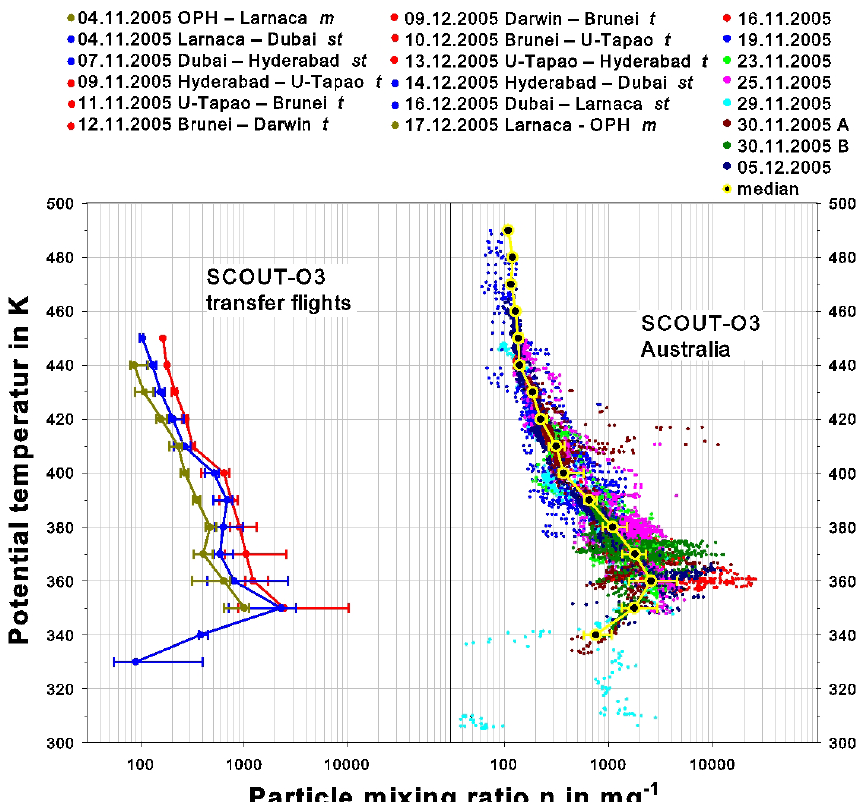
Fig. 4. Vertical profiles of COPAS particle mixing ratios as function of potential temperature (in K) for the transfer to/from Darwin and the local flights in Australia. The symbols are medians of 10K bins and the bars denote 25% and 75% percentiles. Left panel: Vertical n 10 profile measurements during the intermediate descents and ascents from the transfer flight airports between Oberpfaffenhofen (“OPH”, Germany) and Darwin (Australia). The denominations (and colours) refer to the geographical locations of these airports with “m” (dark green), “st” (blue), and “t” (red) standing for “mid-latitude”, “sub-tropical”, and “tropical”. Similarly, the mid-latitude and sub-tropical data are comprehended in the blue and green curves. Right panel: Vertical profiles of n 10 obtained over Darwin. Here the colour code refers to the flight dates on the right side of the legend and the small points represent 15s averages. The potential temperature of the cold point tropopause was near